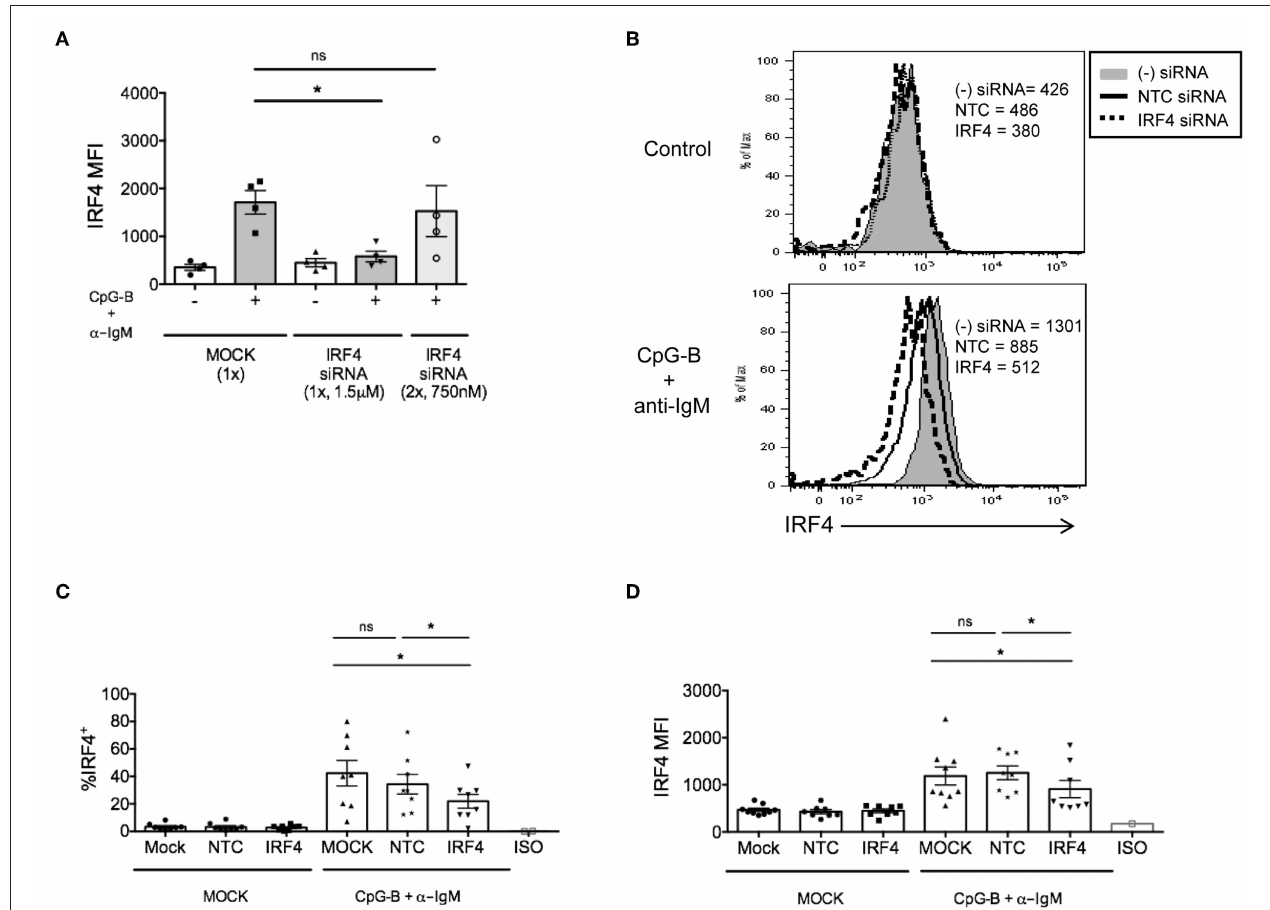
FIGURE 2 | IRF4 knockdown in primary human naïve B cells by Amaxa nucleofection protocol. Isolated human naive B cells were nucleofected with or without IRF4 targeting siRNA and stimulated with or without anti-IgM + CpG-B for 48h. (A) Comparison of single vs. dual nucleofection protocols ( n = 4). (B) Isolated human naive B cells were nucleofected with or without 1.5 µ M IRF4 targeting siRNA or non-targeting control (NTC) siRNA, rested for 24h, and stimulated with or without anti-IgM + CpG-B for 48h. Representative histogram overlays show IRF4 expression after stimulation. (C,D) Similar to B except data are summarized from multiple independent experiments showing % IRF4 + CD19 + IgD + B cells (C) and MFI of IRF4 in CD19 + IgD + B cells (D) from n = 8 independent donors. Paired t -test for significance was performed (* p <